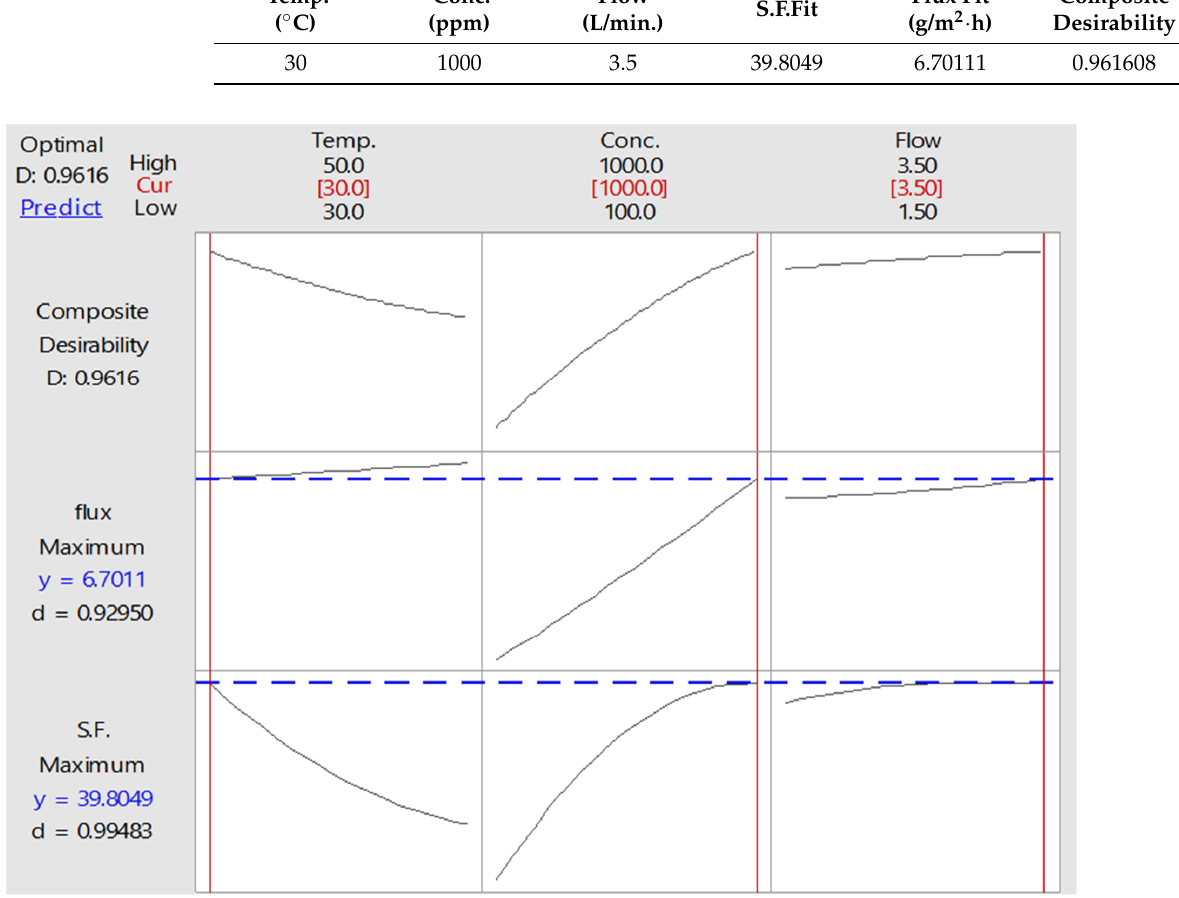
Figure 8. Optimization plot for benzene flux and S.F. for benzene–water